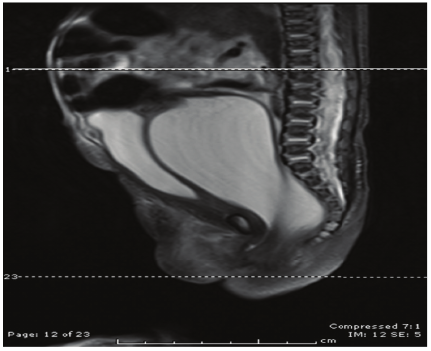
Figure 3: Neonate B: Sagittal T2W image through the abdomen and pelvis demonstrates a fluid-distended vagina between urinary bladder and compressed rectum. The distal vaginal canal is abnor- mally narrow with only a subtle channel identified. Suspicious for vaginal stenosis versus transverse muscular septum given the soft tissue signal which is isointense to